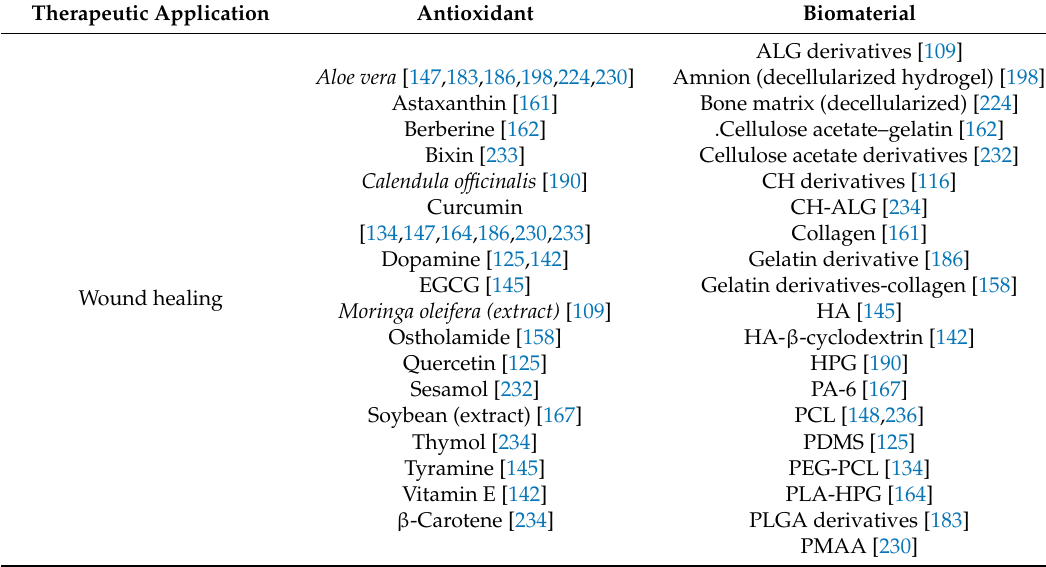
Table 2. Studies demonstrating the potential therapeutic application of biomaterials including natural